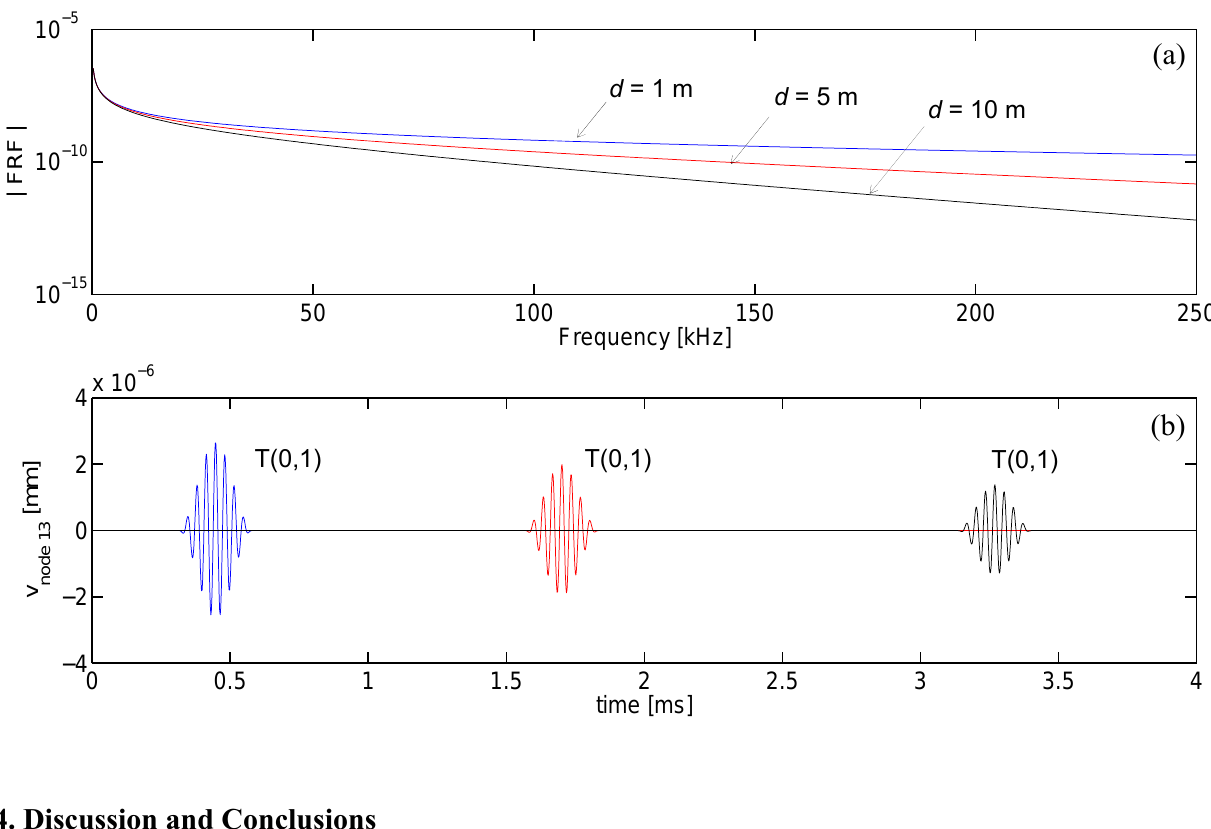
Figure 11 . Response for the y -dof of node 13 at different distances source-receiver d =z . (a) absolute value of the scaled frequency response function, (b) time-transient z S